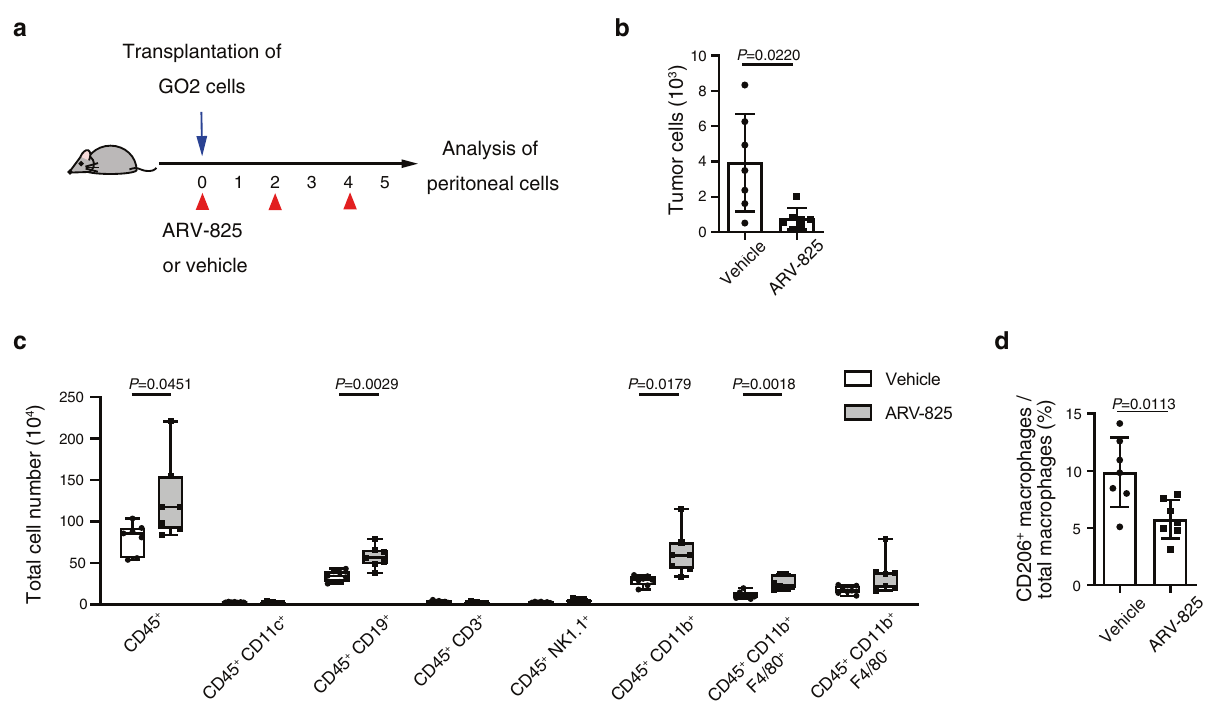
Fig. 8 Treatment with ARV-825 suppresses OC cell survival and blocks induction of CD206 + macrophages in the peritoneal cavity. a C57BL/6 J mice were injected i.p. with GO2 cells and treated i.p. with either vehicle or ARV-825 as indicated. b Flow cytometric quantitation of GFP + (tumor) cells in the peritoneal cavity of mice at 5 days after cell transplantation and treatment with vehicle or ARV-825 ( n = 7 mice each) as in a . c Flow cytometric analysis of CD45 + cells, CD45 + CD11b + myeloid cells, CD45 + CD11b + F4/80 + macrophages, and CD45 + CD11b + F4/80 − cells in the peritoneal cavity of mice at 5 days after cell transplantation and treatment with vehicle or ARV-825 ( n = 7 mice each) as in a . d Percentage of CD206 + macrophages among total macrophages in the peritoneal cavity of mice at 5 days after cell transplantation and treatment with vehicle or ARV-825 ( n = 7 mice each) as in a . All data are means± SD and were analyzed by unpaired t test with Welch ’ s